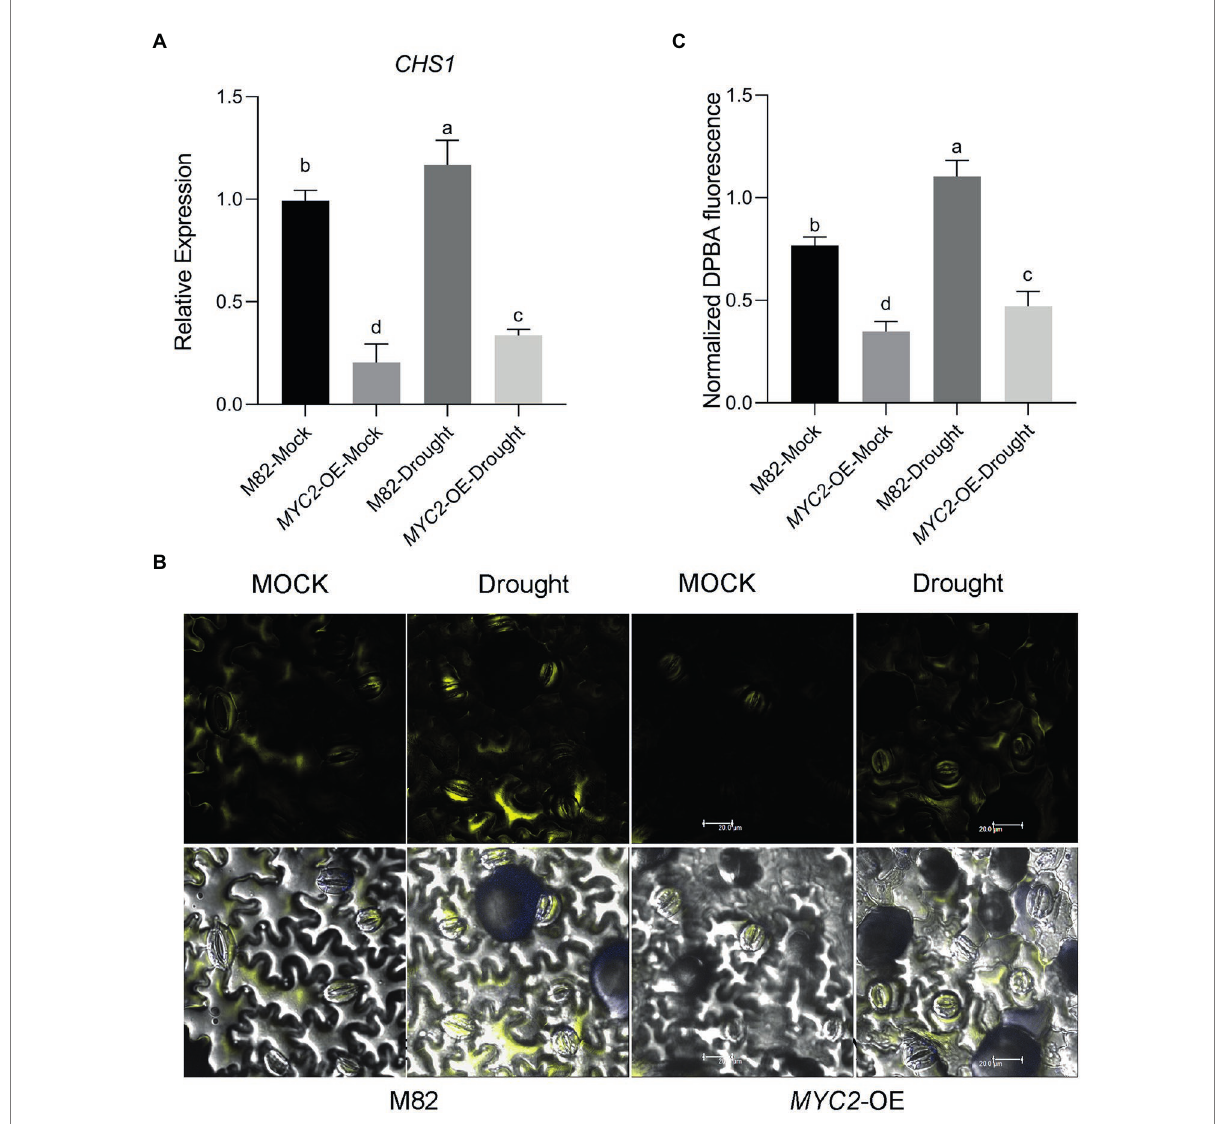
FIGURE 6 Overexpression of SlMYC2 decreased the flavonol content by inhibiting the expression of SlCHS1 in plants under drought stress. (A) The expression of SlCHS1 in tomato guard cells in MYC2 -OE and M82 plants subjected to drought treatment and mock treatment. (B) Confocal micrographs of DPBA-stained guard cells of MYC2 -OE and M82 plants subjected to drought and mock treatments. DPBA fluorescence is shown in yellow (bar = 20 μ m). (C) Quantification of DPBA fluorescence in guard cells (M82: n = 499; MYC2 -OE: n = 493; M82-Drought: n = 498; MYC2 -OE-Drought: n = 505). Data were obtained from three experiments. Different letters represent significant differences ( p < 0.0001), as determined using Tukey’s multiple comparisons